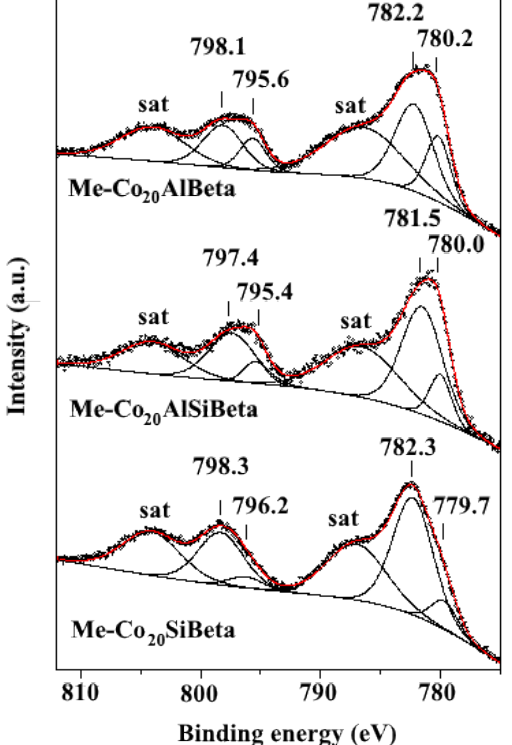
20 Beta zeolites. Catalysts 2019 , 9 , x FOR PEER REVIEW